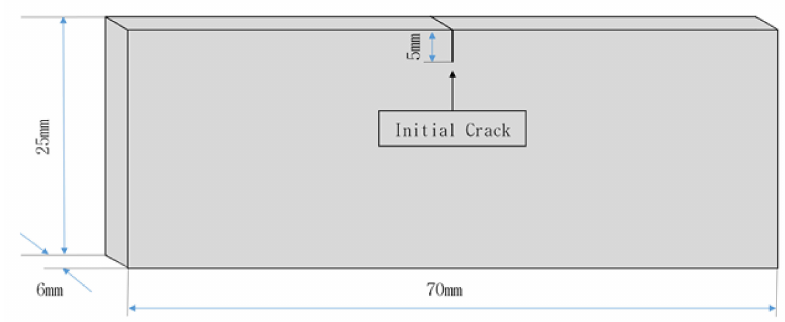
Figure 5. Configuration and dimensions of the tensile test